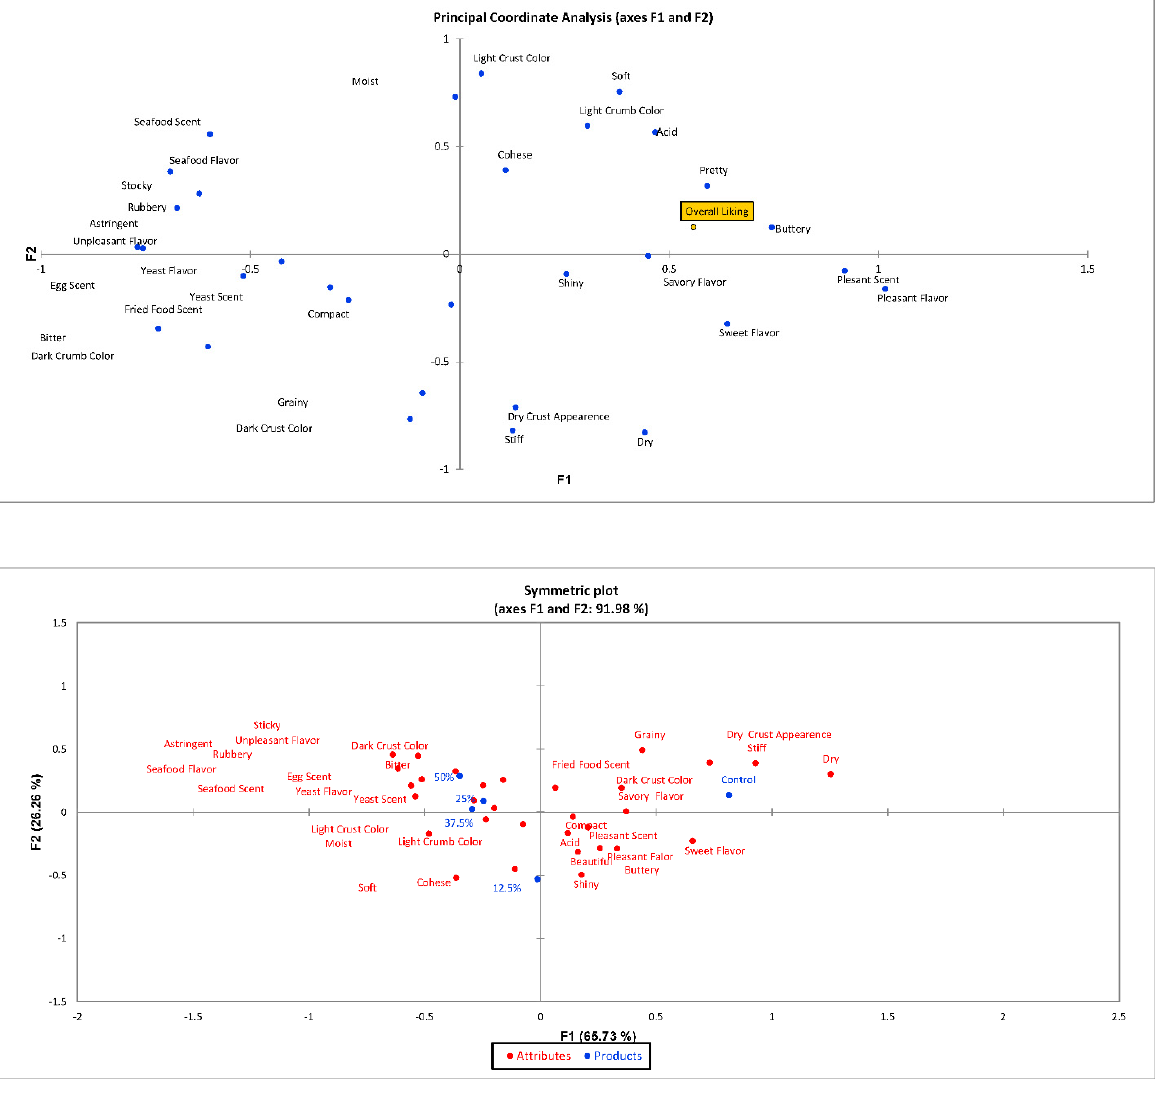
Figure 2. Sensory descriptive map resulting from Correspondence Analysis performed on the CATA data ( n = 110) .